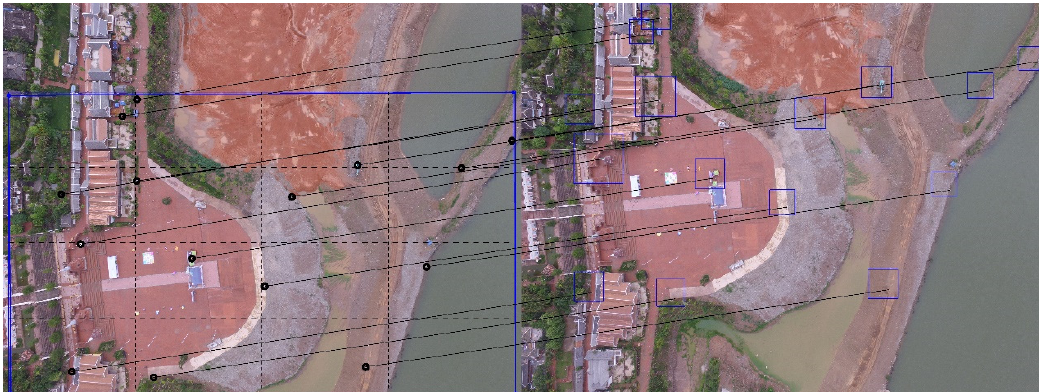
Figure 2. Find the matching feature points in the neighborhood.